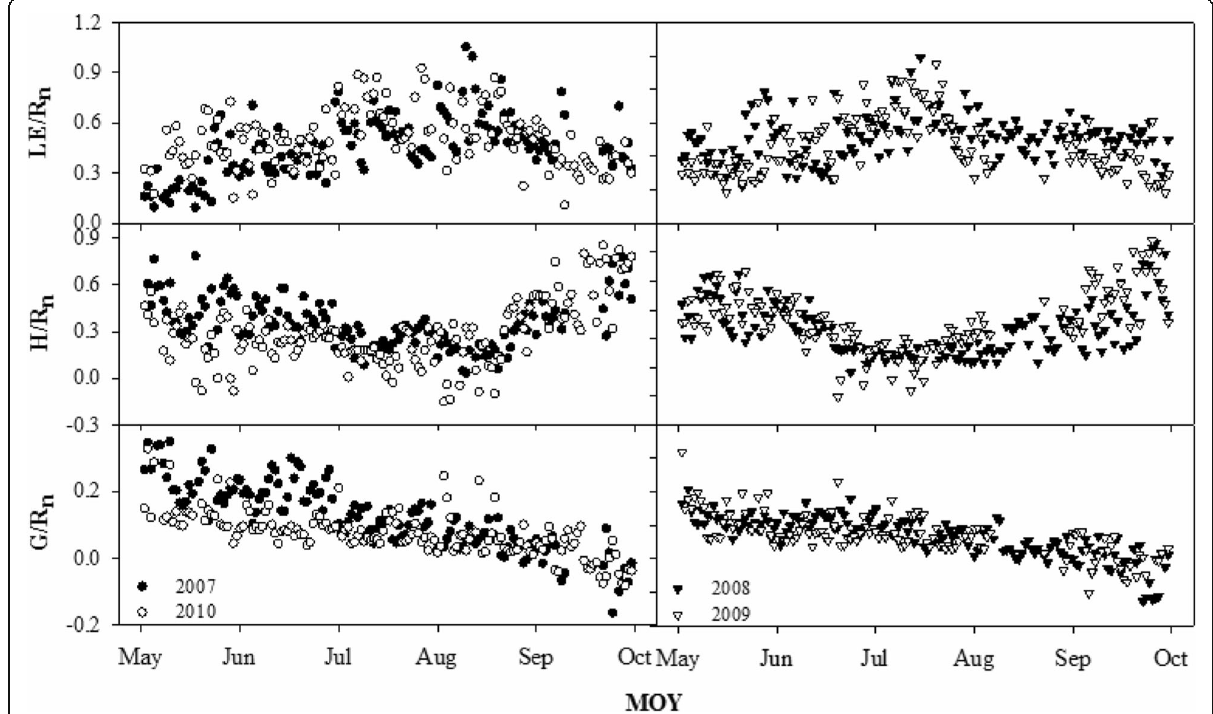
Fig. 5 Growing season fractions of latent heat, sensible heat, and soil heat flux to net radiation (LE/ R n , H / R n , G / R n , respectively) during 2007 –